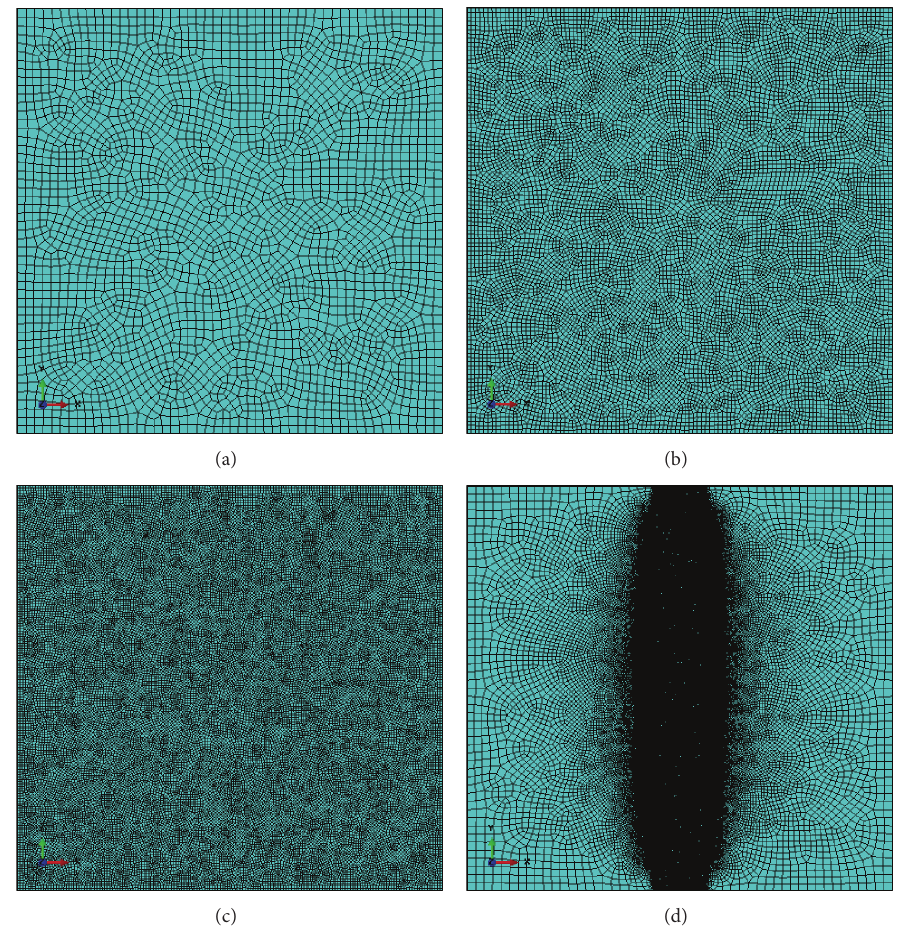
Figure 2: The considered FE representations of the plate based on different element sizes (1.0, 0.5, 0.3, and 0.1mm corresponding to (a), (b), (c), and (d)). The meshes (a)–(c) are referred to as “coarse,” “mean,” and “fine,” whereas mesh (d) is referred to “extra